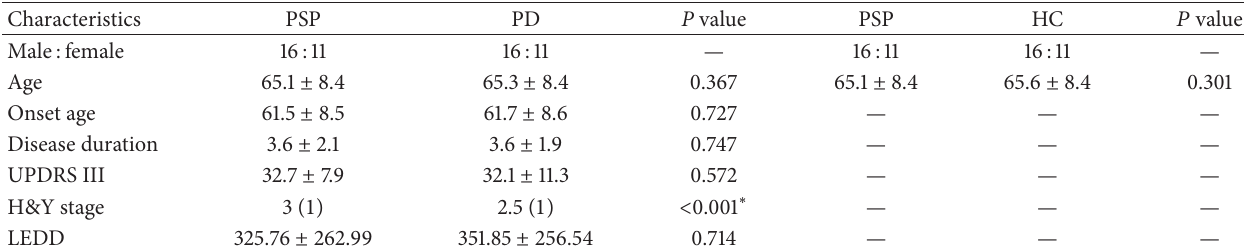
Table 1: Demographic and clinical features of PSP, PD, and HC.